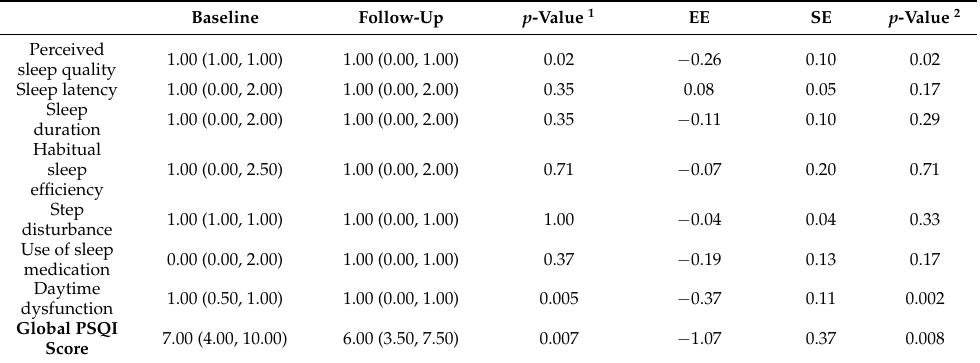
Results of sleep quality evaluation are reported in Table 3. A significant difference between baseline and follow-up was detected for perceived sleep quality and daytime dysfunction. No other changes were detected, and the single components’ scores re- mained stable between baseline and follow-up. The global PSQI evaluation revealed a slight significant improvement. Table 4 reports the QoL, measured with the EQ-5D-5L. Small positive changes were detected in Self-care and Usual activity domains, as well as in the EQ-VAS. Table 3. Single components and global PSQI scores at baseline and follow-up and their estimated change using longitudinal models. Data are reported as the median and interquartile range at baseline and follow-up. Results of the longitudinal model are reported as estimated effect (EE), standard error (SE), and p -value.